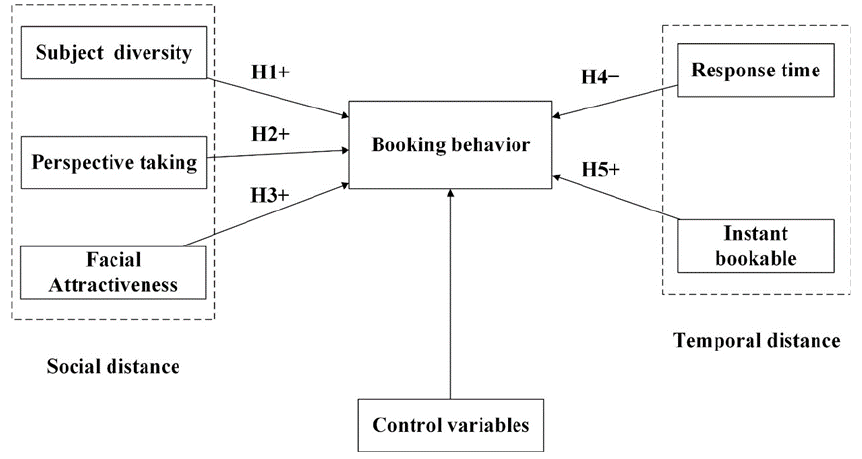
Figure 1. Research